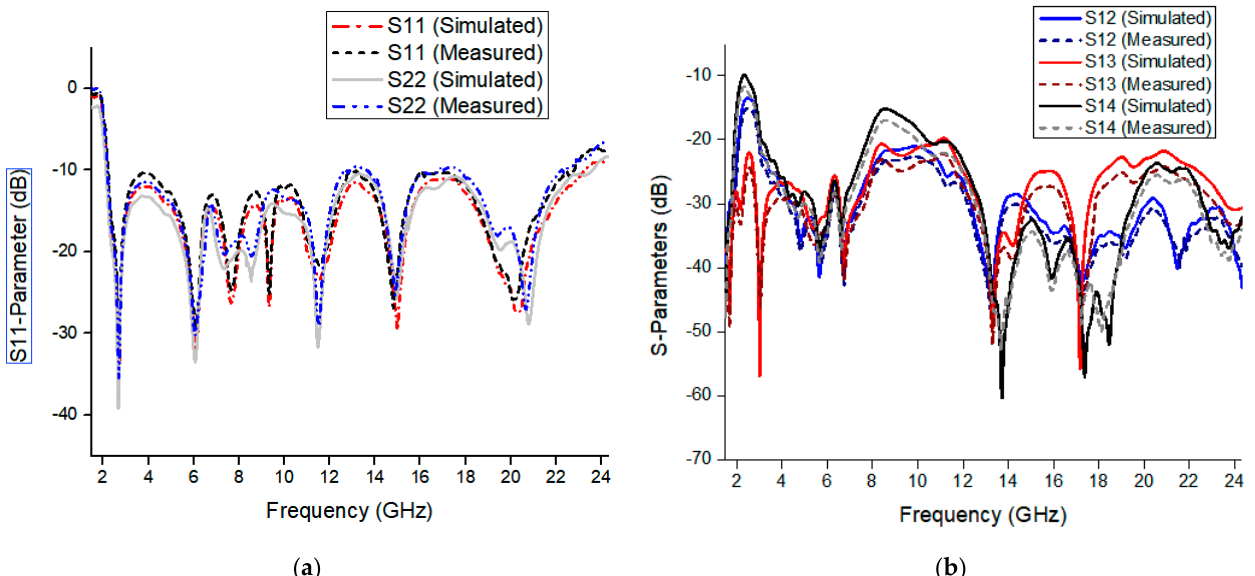
Figure 11. Measured and simulated S-parameters of the proposed MIMO antenna with respect to port1. ( a ) S-parameters and ( b ) isolation.